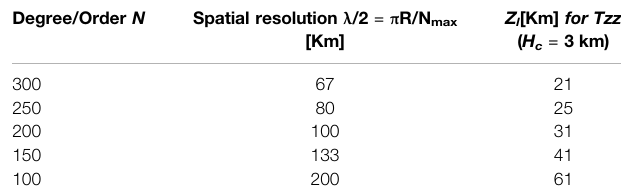
TABLE1| Approximateddepth(Z l )ofacausativemassforadetermineddegreeof the spherical harmonic expansion for Tzz and corresponding spatial resolution (Alvarez et al., 2017a).